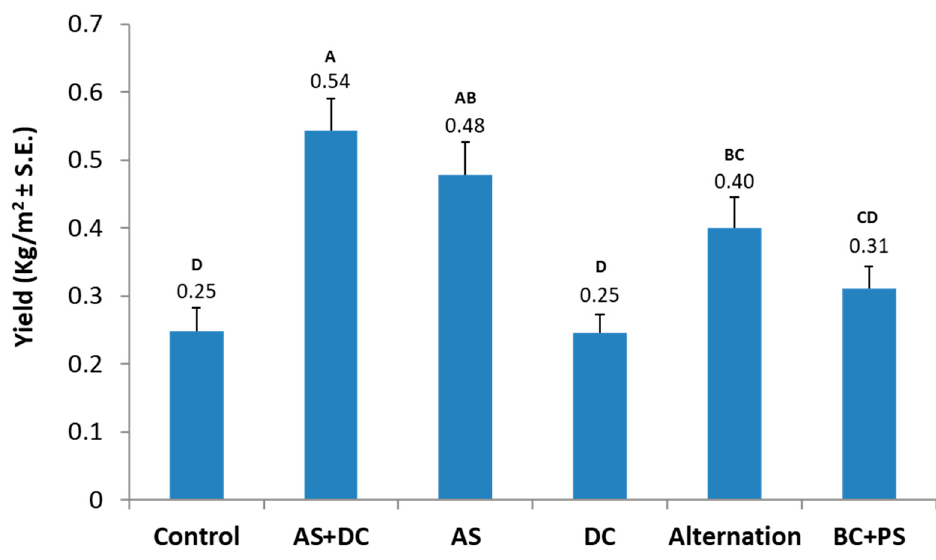
Figure 8. Yield assessment (Amir, summer 2018). The assessment was carried out 21 DAF (76 DAS). Values indicate an average of 10 replications. Upper bars are standard errors. Levels not connected by the same letter (A, B, C, D) are significantly different ( p < 0.05, ANOVA).